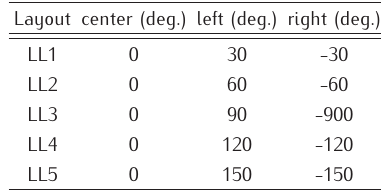
Table 2. Loudspeaker locations.